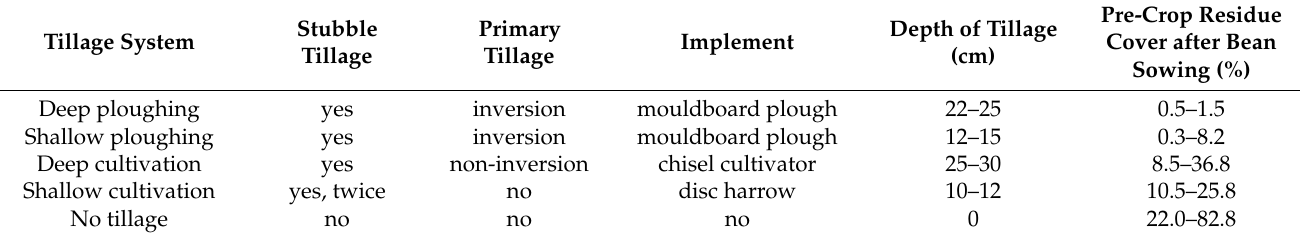
Table 1. Tillage practice in the experiment,